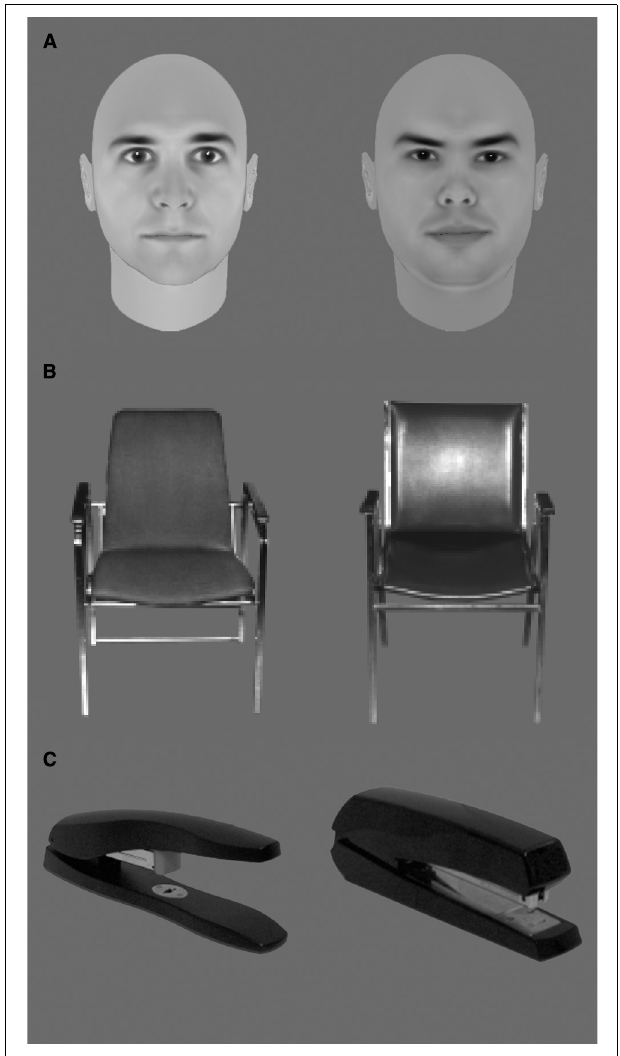
FIGURE 2 | Examples of stimuli used to trigger within-class discriminations that are equivalent for faces (A) and other complex objects